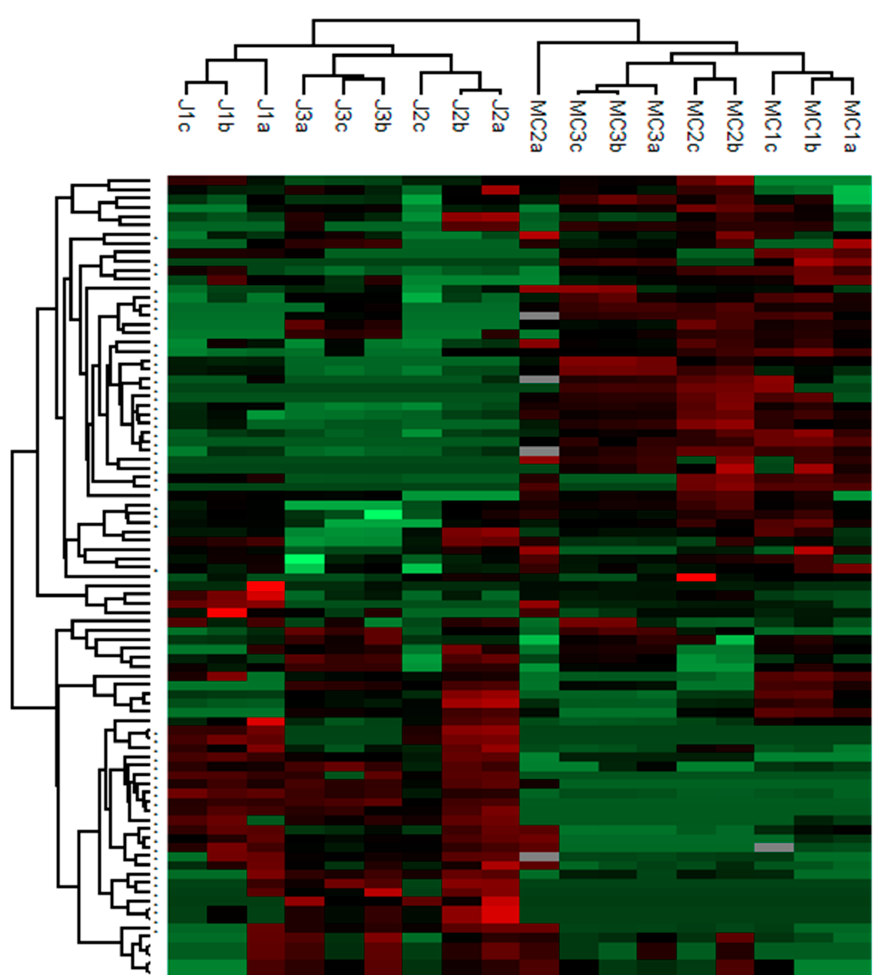
Figure 1. Hierarchical cluster analysis (HCA) performed on all normalized volatile compound areas in gentian roots from the two sampling sites.